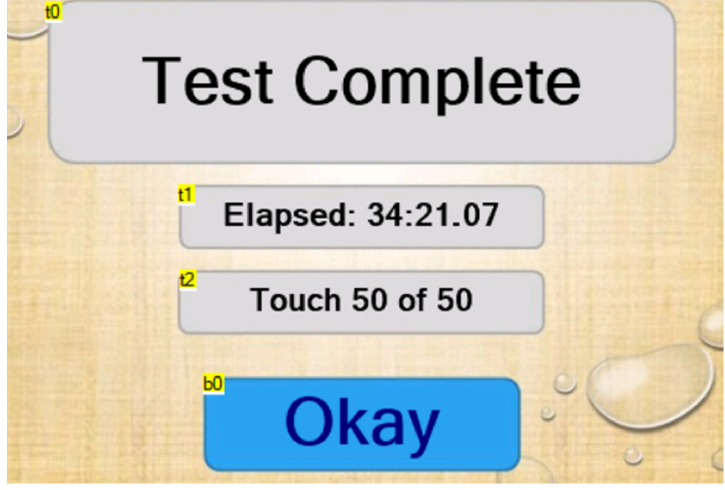
Figure 7. “ Test complete” page. Figure 7. “Test complete” page. Table 10. Description of each text field found on the “test complete”